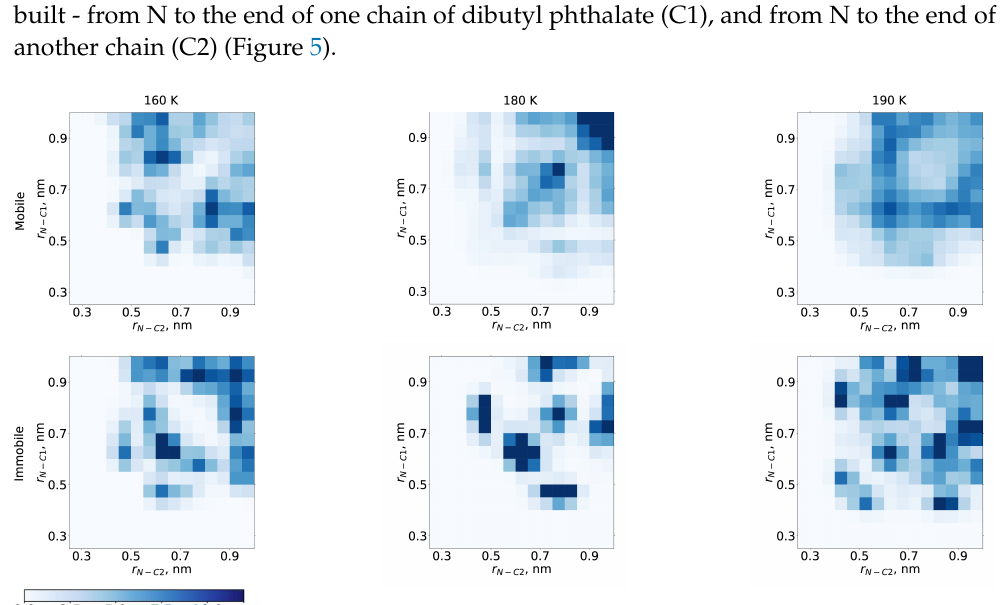
Figure 5. Distribution of distances to chain ends (C1 and C2) of DBP molecules for mobile ( top row ) and immobile fraction ( bottom row ) with temperature 160 K ( left ), 180 K ( middle ), 190 K ( right ). The coordinates correspond to the distances from the first (C1) and second chain ends (C2) of DBP to nitrogen atom of TEMPO